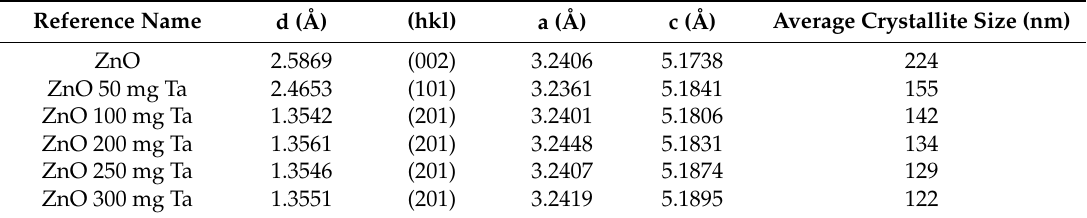
Table 1. Lattice parameters and crystallite size for ZnO and ZnO:Ta-doped films